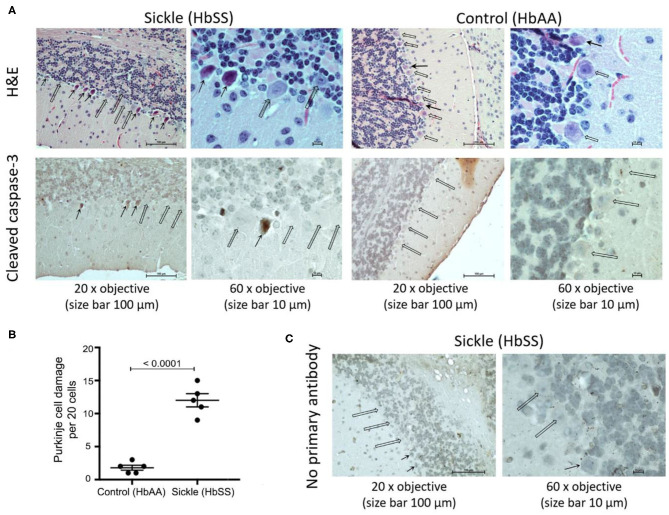
Sickle mice show increased Purkinje cell damage compared to control mice. Cerebellum from ~3.5 month old female HbSS-BERK sickle and HbAA-BERK control mice. (A) H&E and capase-3 stained sections of cerebellum at 20x objective, size bar 100 μm and at 60x objective, size bar 10 μm. Open arrows: normal Purkinje cells with well-organized nucleus. Solid arrows: apoptotic Purkinje cells with smudged and irregular nuclei with condensed chromatin. (B) Quantification of Purkinje cell apoptosis per 20 cells/mouse brain from 5 control 5 sickle mice (unpaired two-tailed t-test). (C) Incubation of sickle mice brain sections without primary antibody showed no cross reactivity with secondary antibody as a negative control. Open arrows: normal Purkinje cells. Solid arrows: apoptotic Purkinje cells with smudged irregular nuclei.